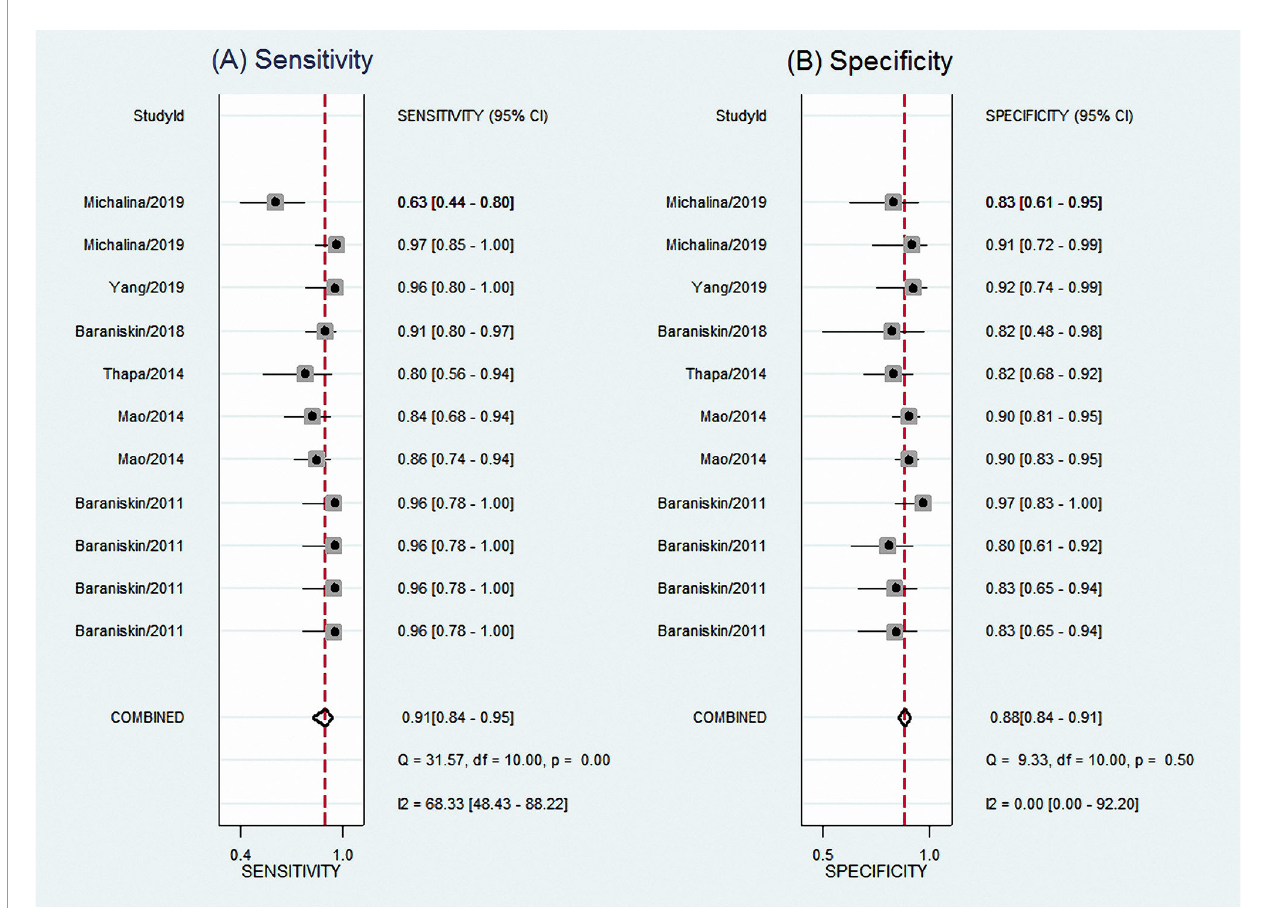
FIGURE 2 | Forest plots of sensitivities (A) and speci fi cities (B) for total miRNA levels of 11 studies in the diagnosis of PCNSL. PCNSL, primary central nervous system